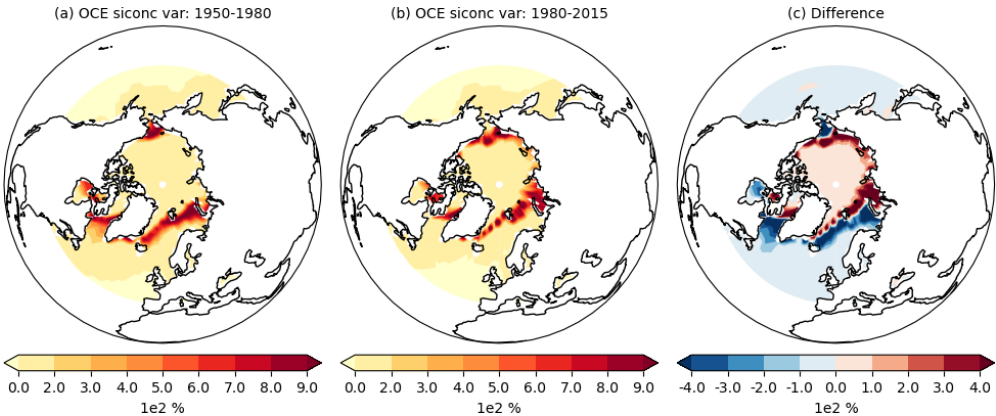
Figure B3. Sea ice concentration variance in November. In (a) the OCE ensemble over the period 1950–1980, (b) the OCE ensemble over the period 1980–2015, and (c) the difference of (b) minus (a) .